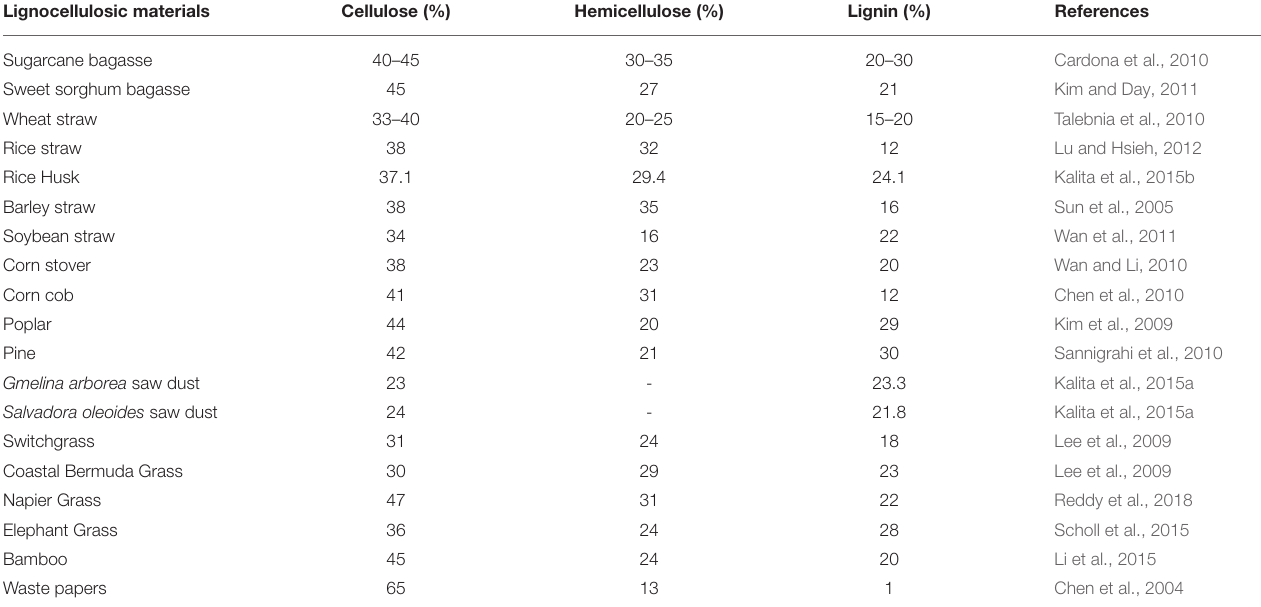
TABLE 1 | Composition of various lignocellulosic